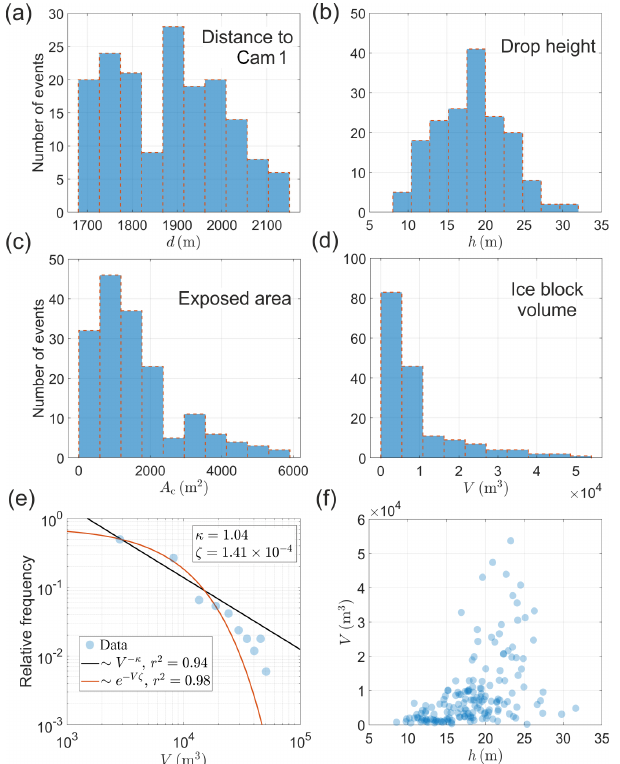
Figure 5. Histograms of (a) distances between Cam 1 and locations of calving events, (b) drop heights, (c) exposed areas of the glacier terminus and (d) estimated iceberg volumes. (e) Distribution of ice- berg volumes divided into 10 bins, presented on log–log scale. The black line shows best-fit power-law (decay exponent κ ) distribu- tion model. (f) Relationship between iceberg drop height and vol- ume. The Pearson correlation coefficient is 0.47 and 0.55 for log- transformed and non-transformed variables, respectively.